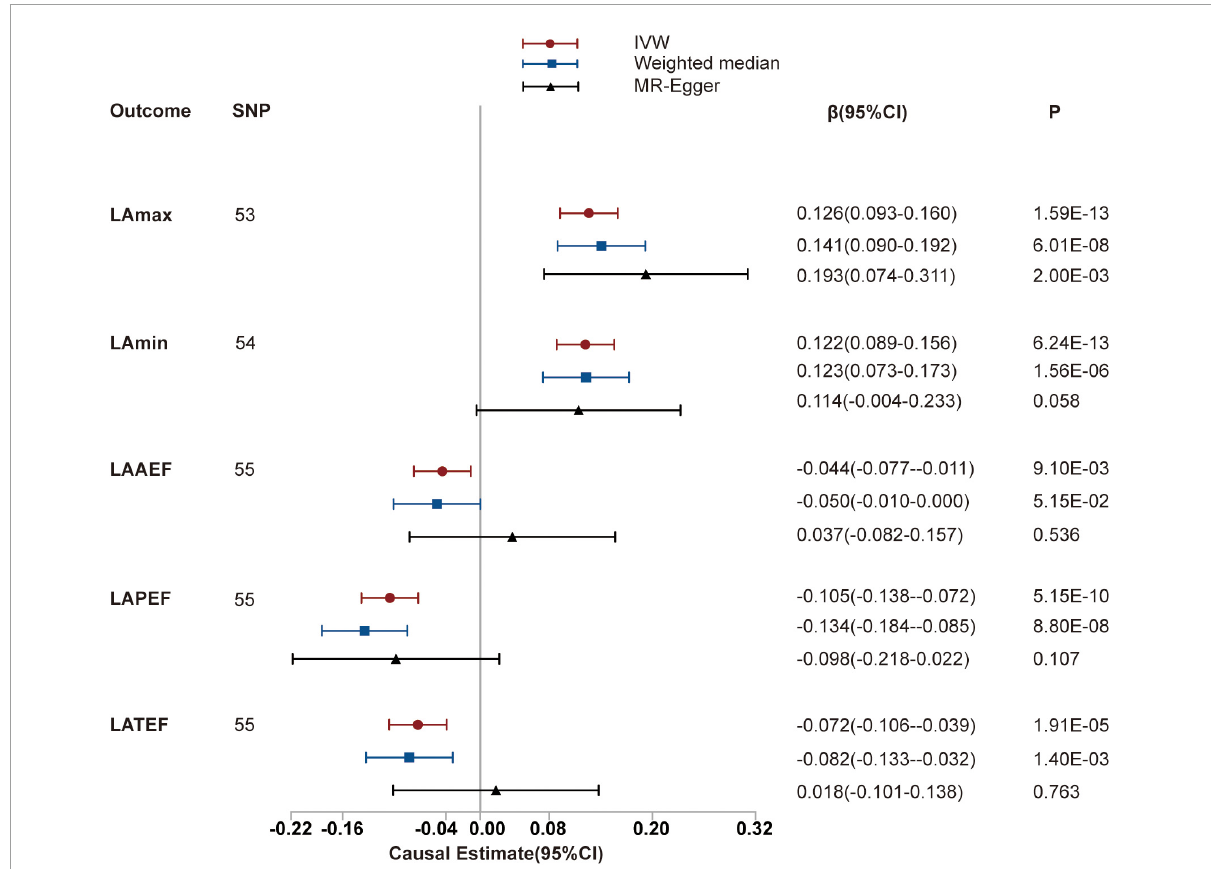
FIGURE2 Mendelian randomization (MR) analyses testing the effect of hypertension on left atrial index. Results of three MR methods [inverse-variance weighted (IVW), MR-Egger and weighted median] are presented as causal estimates with 95%